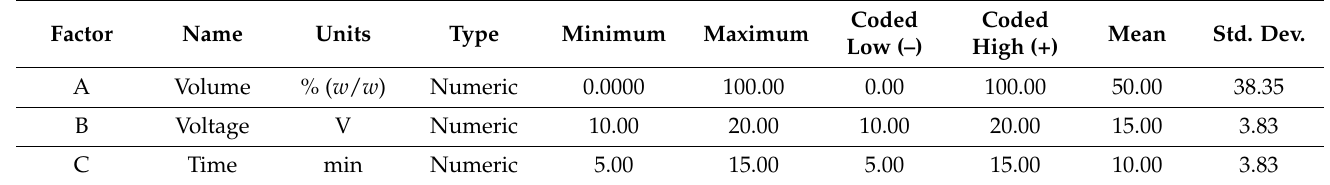
Table 1. Input factors used in the experiment for a volume ratio of 0 and 100%